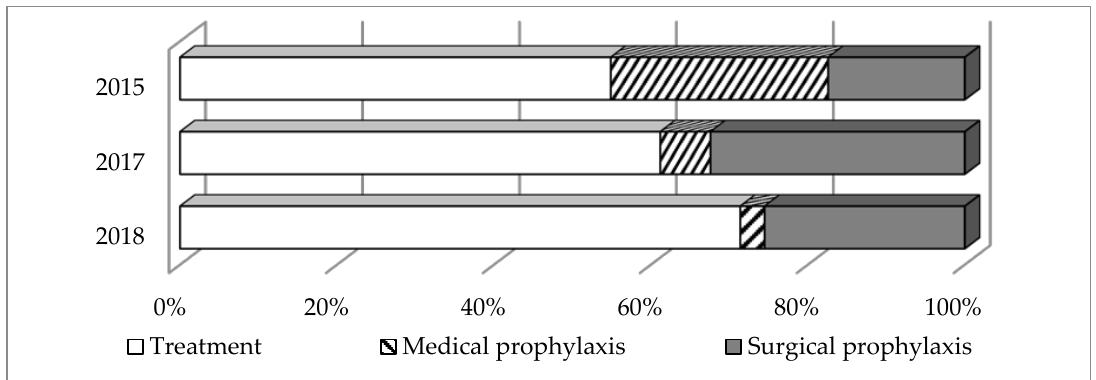
Figure 1. Antimicrobials use by indication.